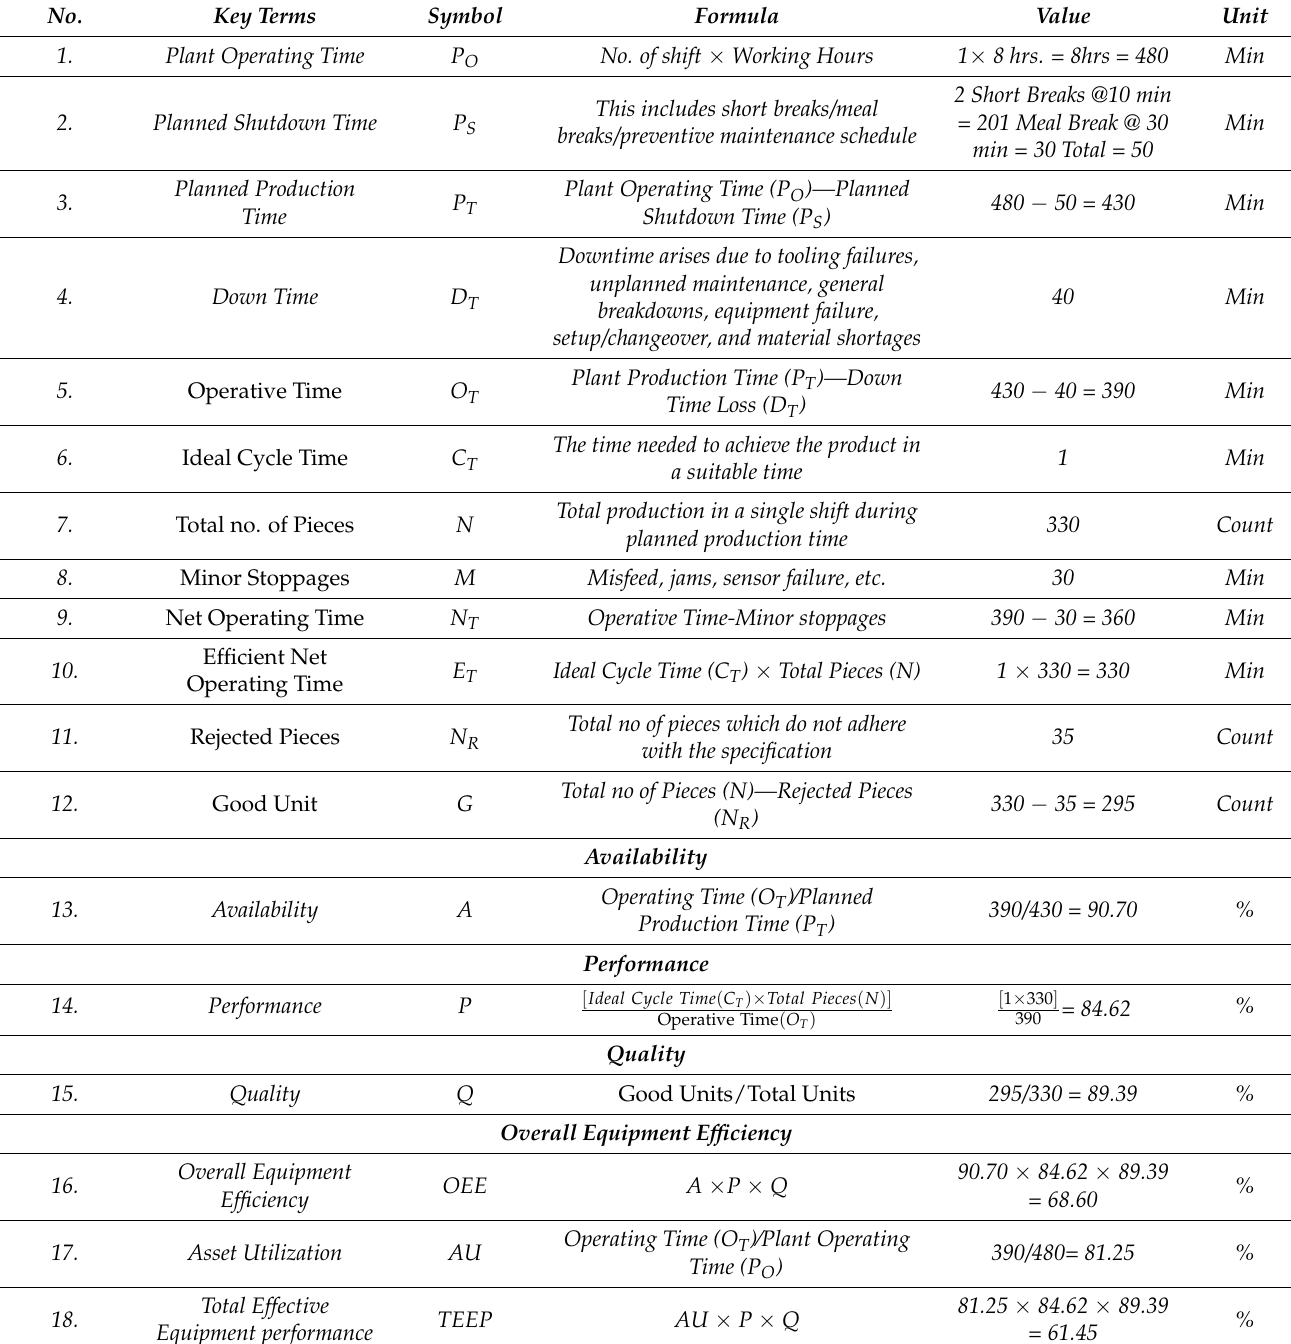
Table 1. Key parameters of